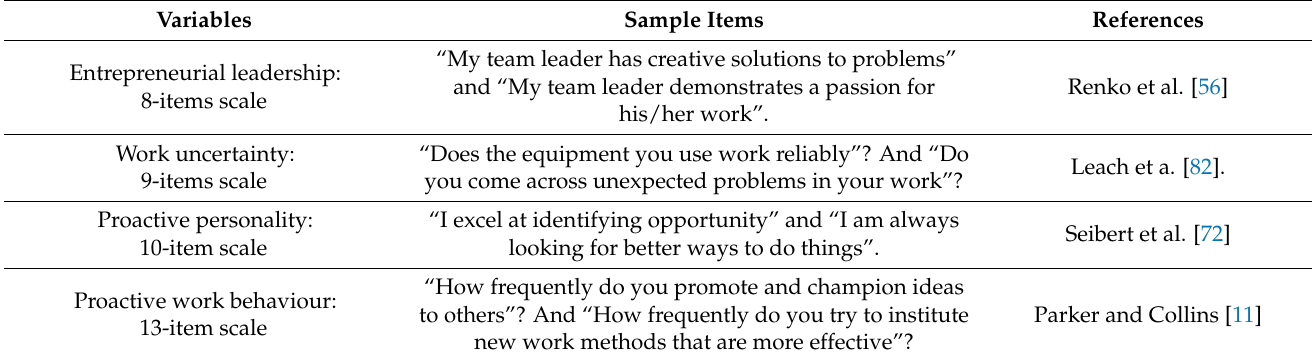
Table 1. Study variables measures.